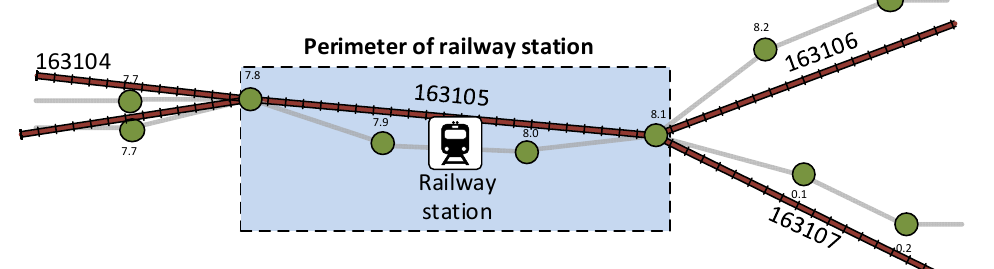
Figure 10. Sample formation of super-edges.